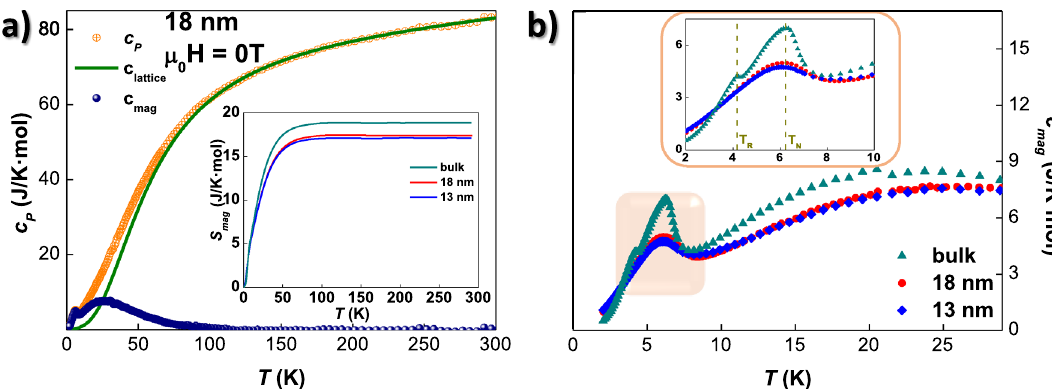
Figure 3. Zero-field specific-heat results. ( a ) Experimental c P (orange), calculated c lattice (green) and c mag (blue) contributions corresponding to 18 nm-sized NdCu 2 MNPs. Inset compares S mag calculated for bulk (dark cyan), 18 nm (red), and 13 nm-sized (blue) MNPs. ( b ) c mag contribution of bulk, 18 nm, and 13 nm-sized MNP alloys. The inset provides a closer view on the magnetic transition region, where the positions of the Néel ( T N ) and reorientation ( T R ) temperatures have been marked by dashed vertical